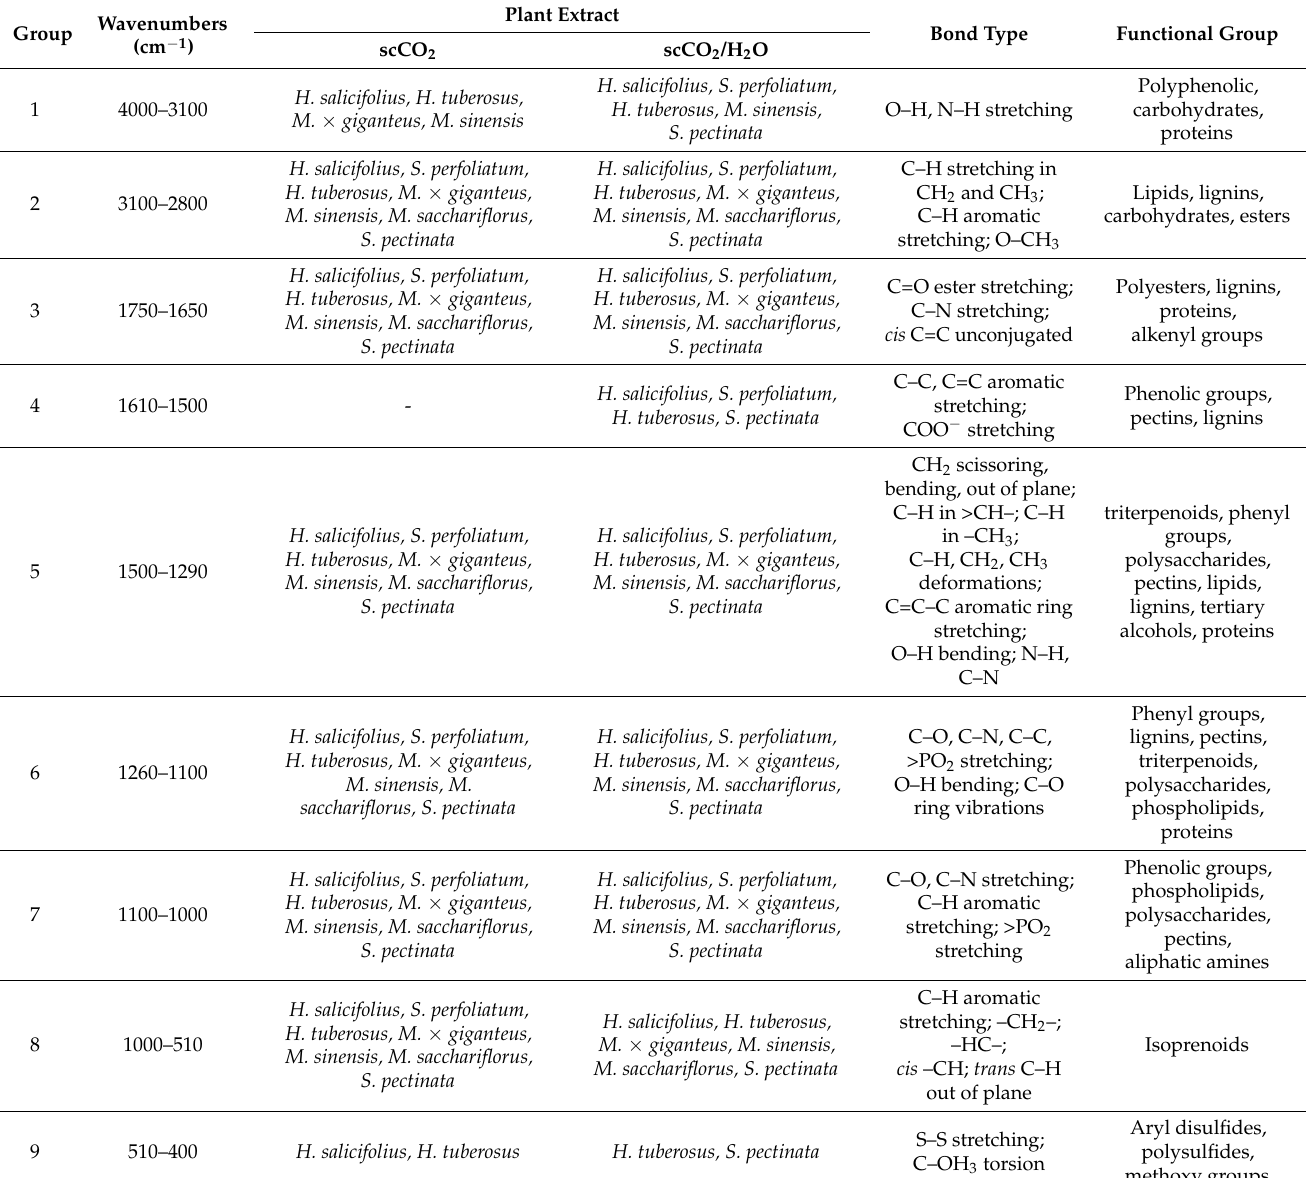
Table 4. Identification of functional groups of supercritical plant extracts (scCO 2 and scCO 2 /H 2 O) harvested in June (analysis based on literature